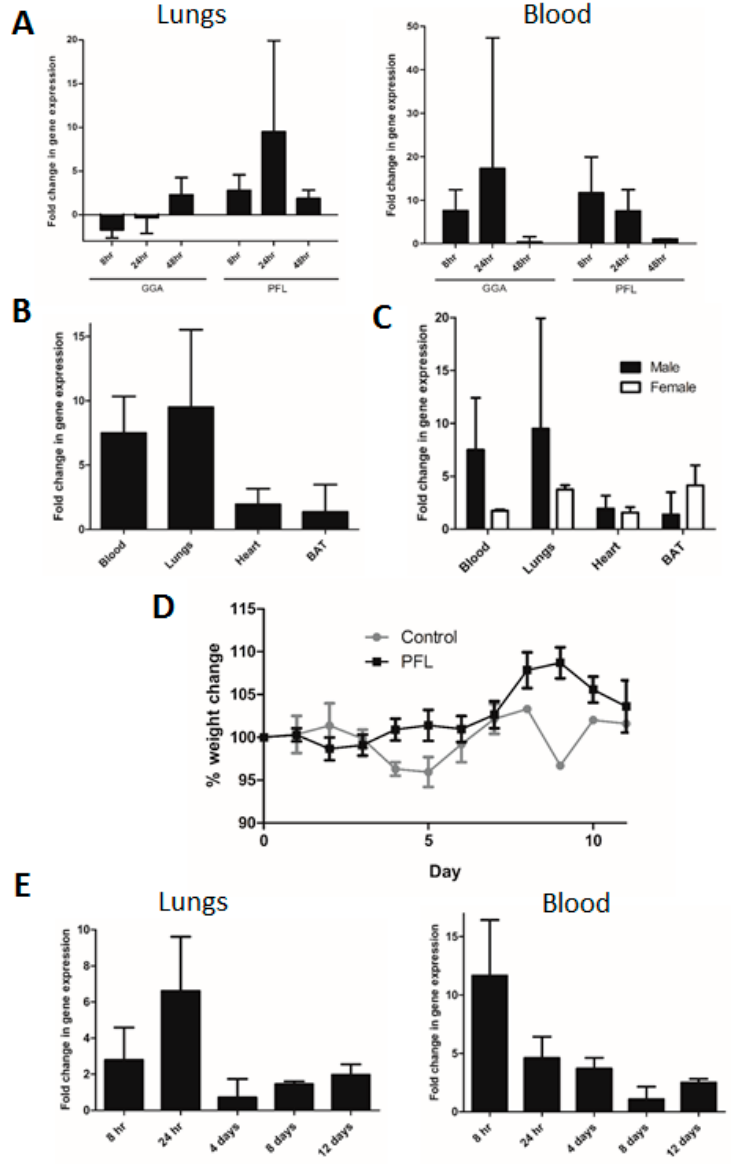
Figure 2. Induction of heat shock protein 70 (HSP70) expression in deer mice. ( A ) Levels of HSP70 expression were assessed in either the blood or the lungs as compared with the vehicle-treated